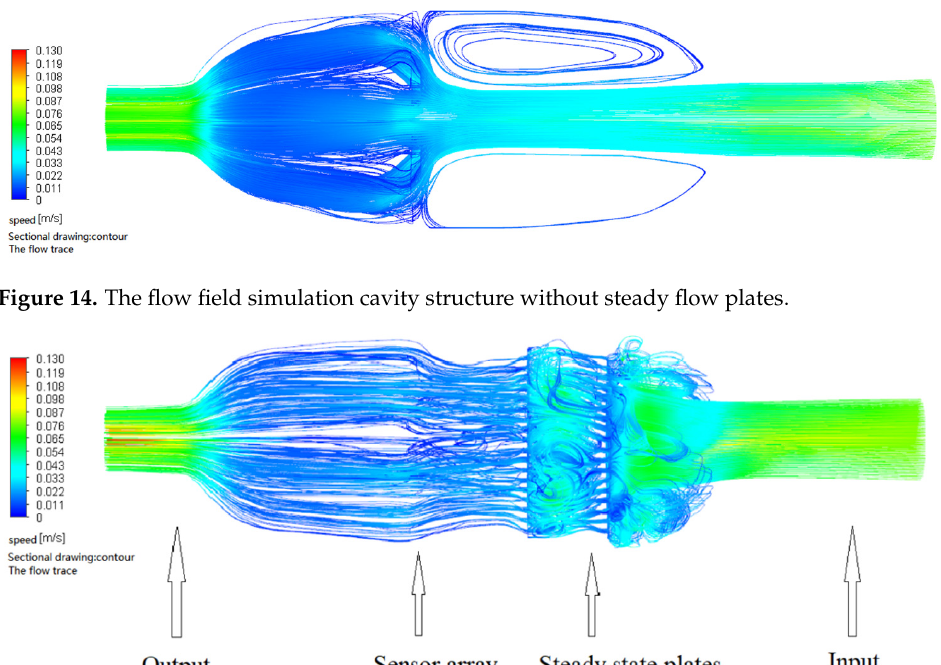
Figure 16. The overall design of the electronic nose.